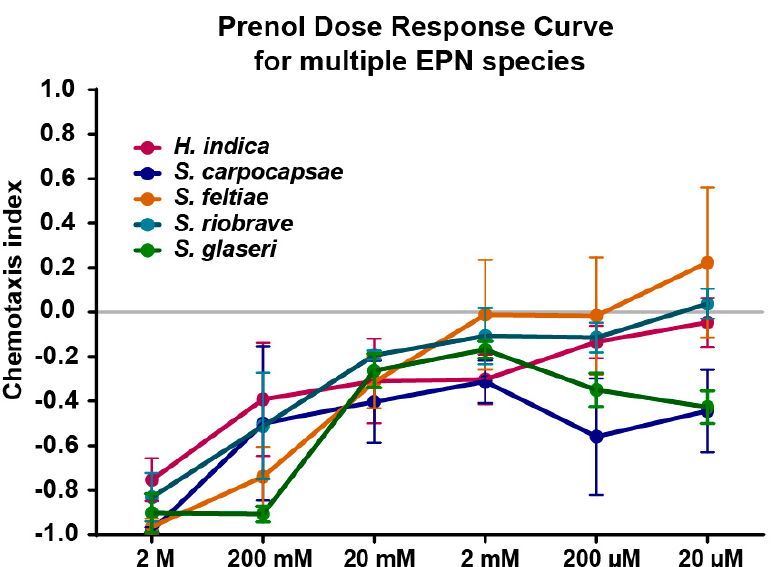
Figure 1. Dose response curve results for multiple EPN species (4-h post-collection IJs). Results of a